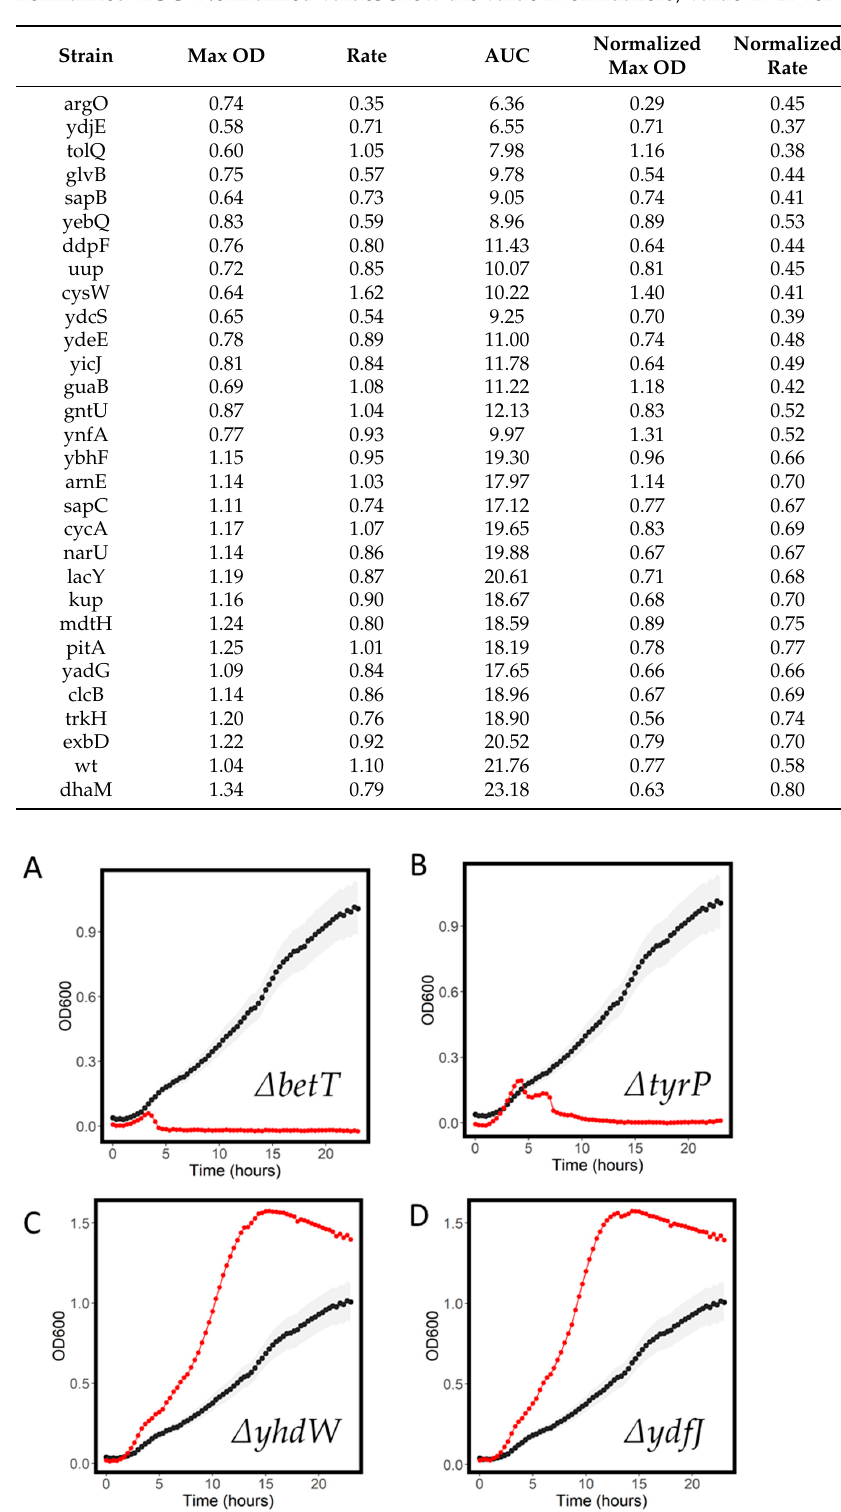
Figure 6. Growth curves for WT (black) and knockout strains (red) in 400 mg/L azithromycin. ∆ betT ( A ), ∆ tyrP ( B ), ∆ yhdW ( C ) and ∆ ydfJ ( D ) are shown. Shaded areas represent the standard deviation for the WT growth curve.